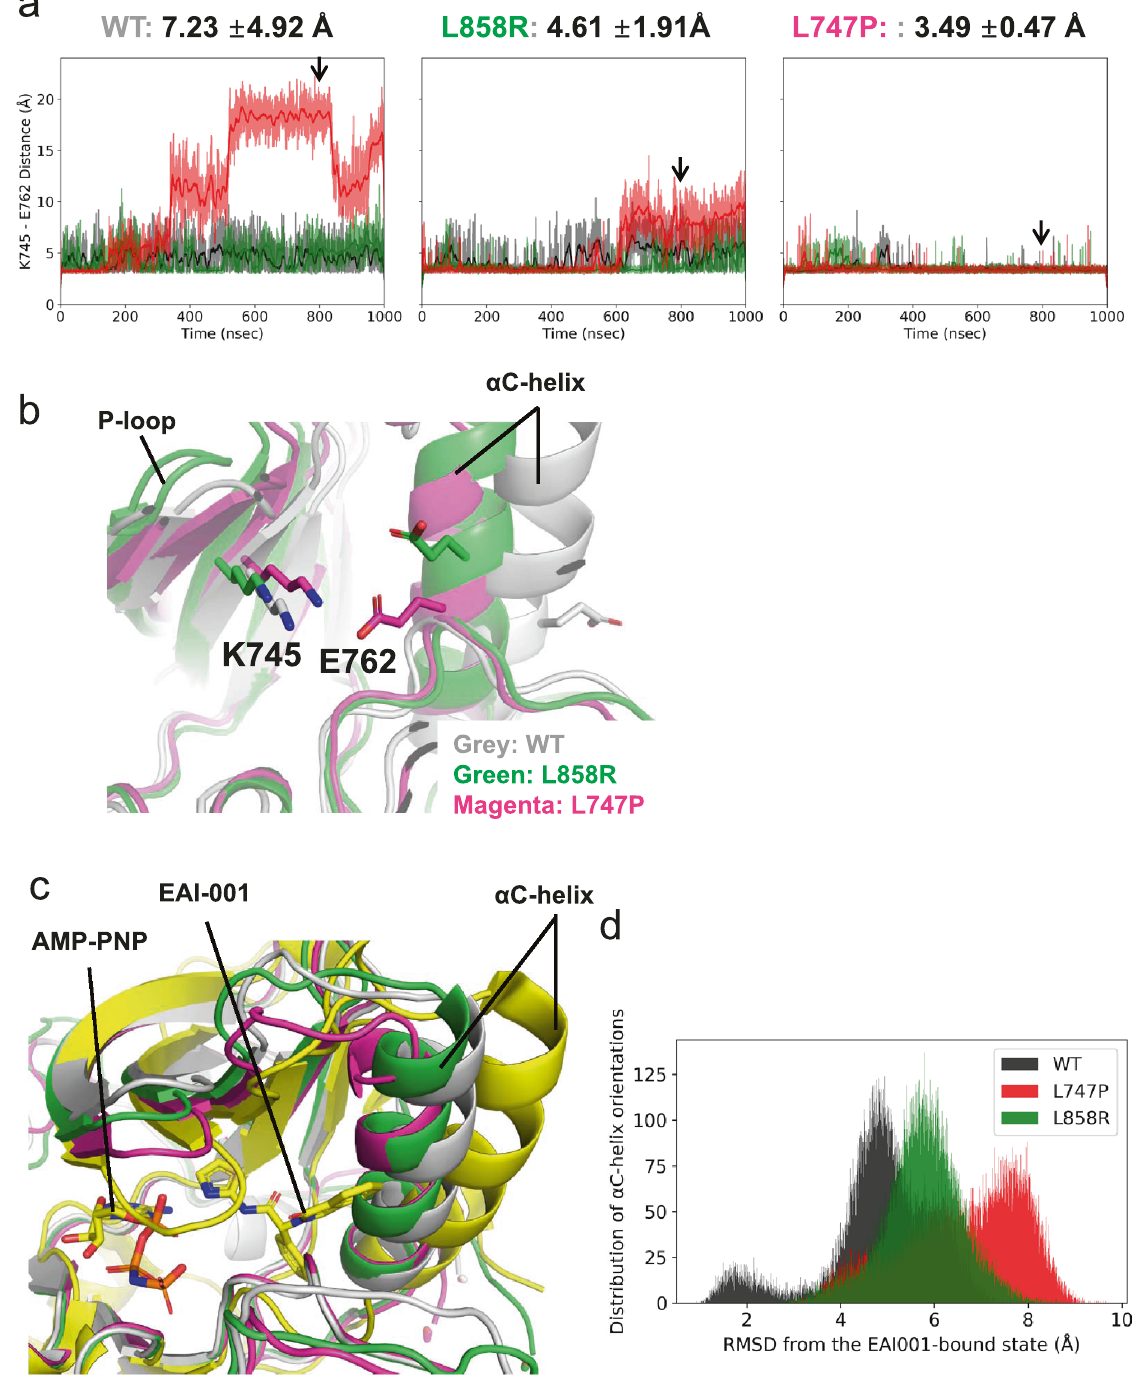
Fig. 6 Conformational preferences of EGFR-WT, L858R, and L747P mutants. a Stability of the Lys745-Glu762 salt bridge in 1 ms × 3 MD simulations. The distance between Lys745 Nz and Glu762 Cd atoms is plotted every 100 ps (thin lines), and smoothed by a window average of 10 ns (thick lines). An average and the standard deviation across three independent trajectories (black, red, and green) ranging from 100 to 1000 ns are indicated. b EGFR conformations corresponding to snapshots at 800 ns (indicated by arrows in ( a )). The protein backbone is represented by a ribbon diagram, and the side chains of K745 and E762 are depicted as sticks (C, gray/green/magenta; N, blue; O, red). c Superimposition of the MD structures of the EGFR-WT (gray), L858R (green), and L747P (magenta) mutants and the crystal structure of EGFR (T790M/V948R) bound to an allosteric inhibitor (PDBID: 5D41, yellow). MD structures used are the same as in Fig. 3b, and the allosteric inhibitor (EAI-001) and AMP-PNP observed in the cocrystal structure are depicted as sticks. d Distribution of the conformational orientations of the α C-helix (residues Ser752-Ala767) observed in 1 ms × 3 MD simulations. Root-mean-square deviation (RMSD) from the crystal structure of the EGFR - EAI-001 complex (PDBID: 5D41) was calculated after their backbone Ca atoms were structurally